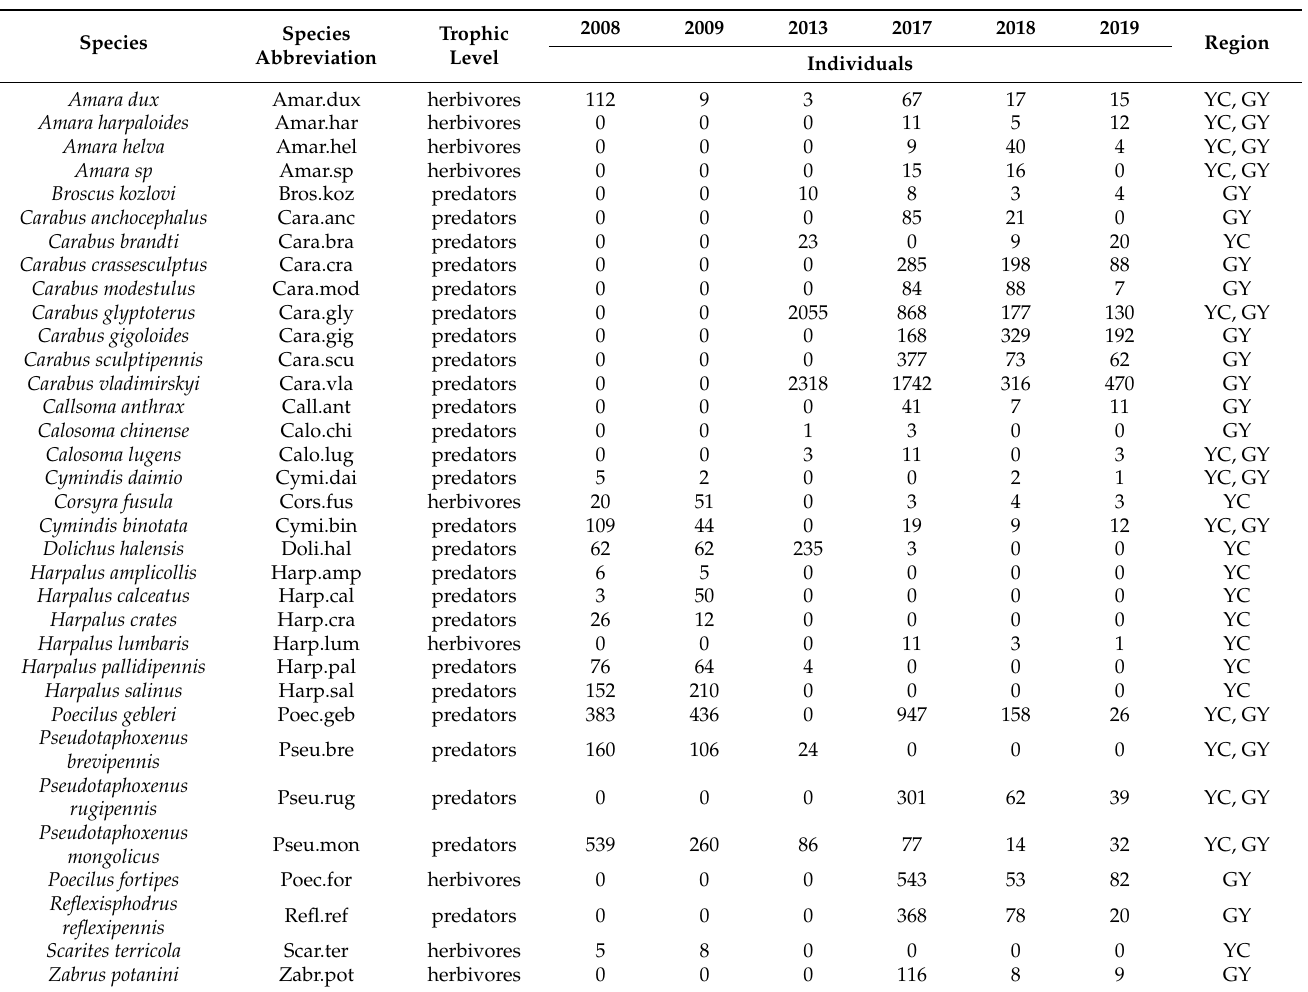
Table A2. List of captured and analyzed beetle species. The column “Individuals” is the sum of total catches per year.